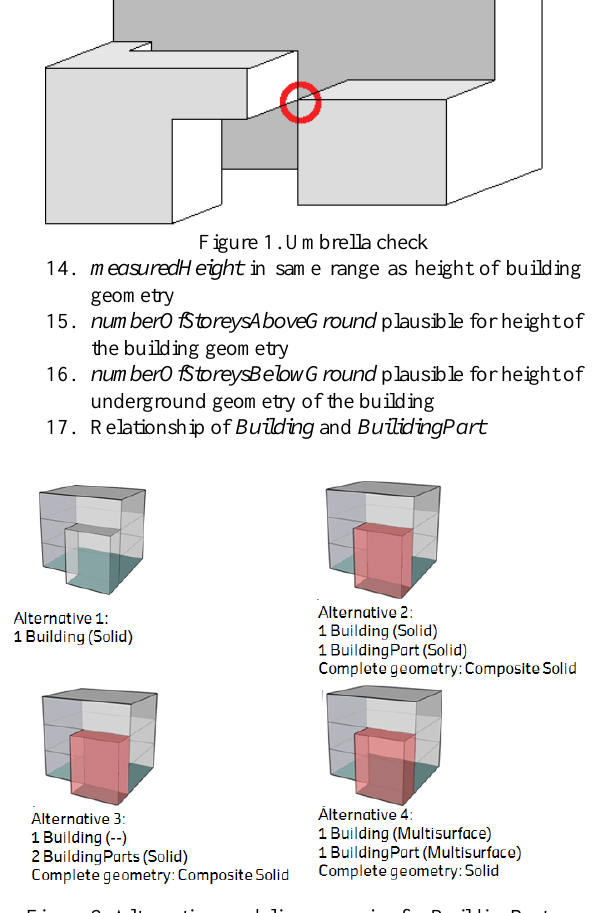
Figure 2. Alternative modeling scenarios for